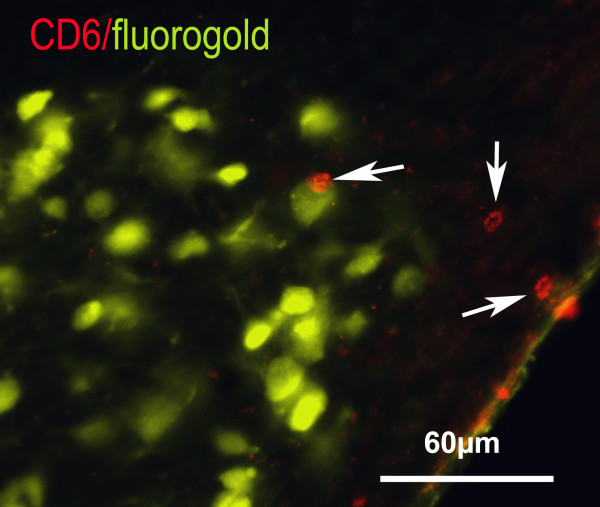
CD6-positive cells (some arrowed) accumulate in the TRN close to a graft in the thalamus. TRN neurons regenerating axons into the graft were retrogradely labelled with fluorogold. The space in the bottom right corner is a blood vessel.